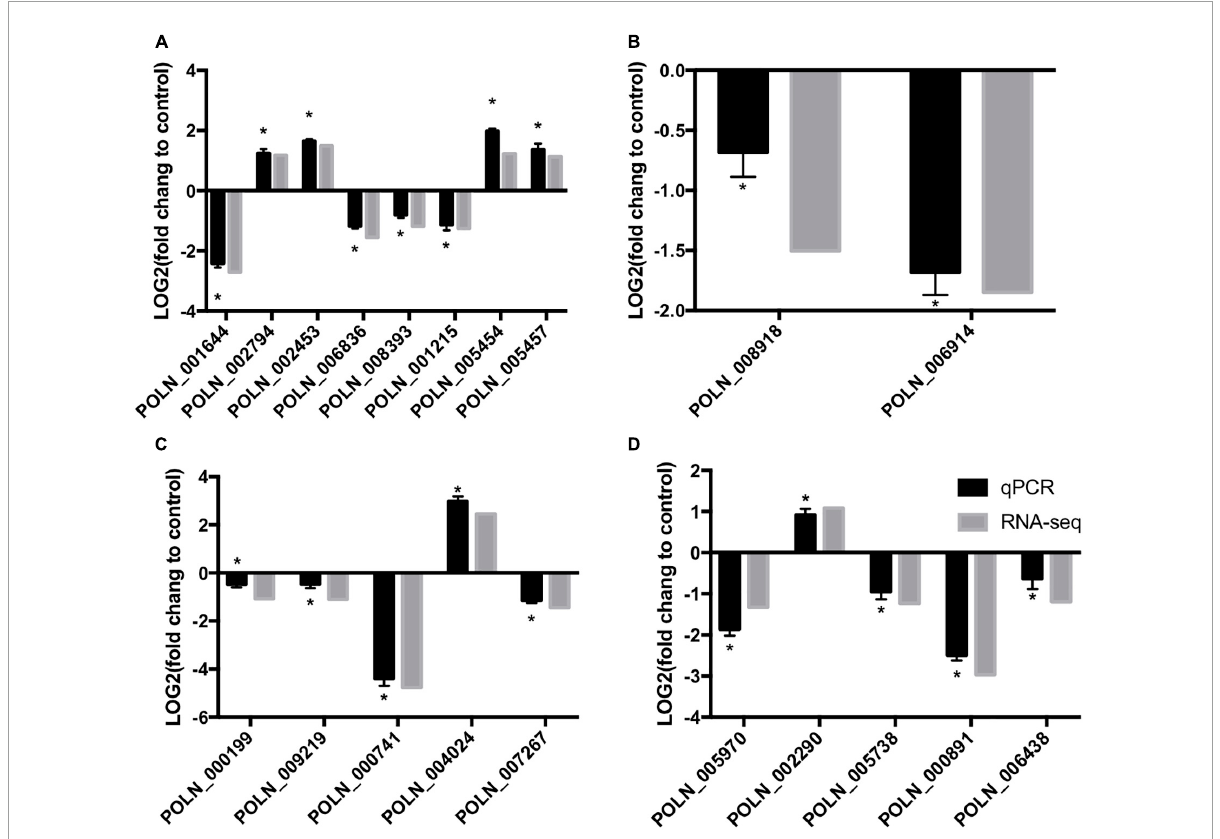
FIGURE12 qRT-PCR verification of RNA-sequencing results with genes involved in sugar metabolism (A) , alternative carbon metabolism (B) , glutathione metabolism (C) , and plant–pathogen interactions (D) . Log 2 (fold change) > 0 represents up-regulation of gene expression, Log 2 (fold change) < 0 represents down-regulation of gene expression. An asterisk above an error bar indicates a significant difference between the treatment group and the control group ( P <